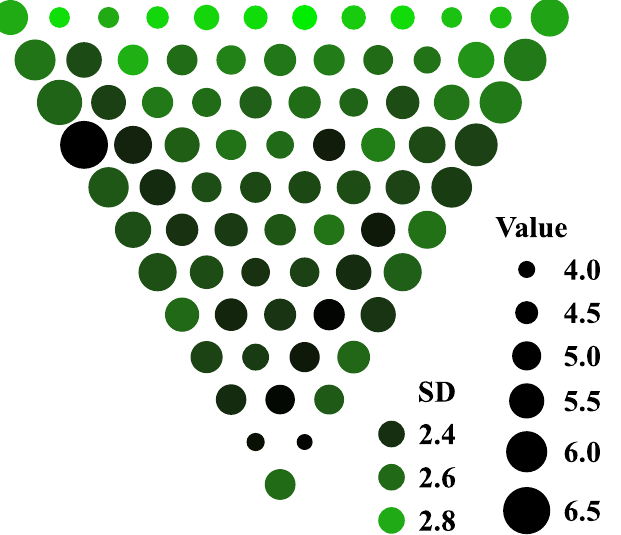
Fig 3. Average stimulus. Stimuli were selected to maximize the ability to infer planning strategies from the observed behavior. The average stimulus is colored by the variability of disk size. Disk size represents the average size across all trials. Disk variability is the highest on the last row. “ SD ” stands for standard deviation. Four examples of the actual stimuli are shown in Fig